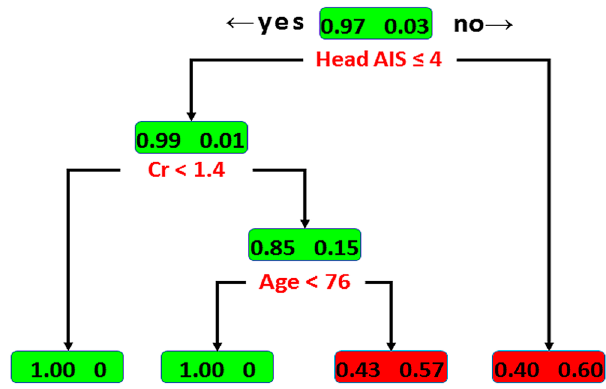
Figure 1. Illustration of the decision tree (DT) model for mortality of patients with isolated traumatic subarachnoid hemorrhage. The boxes denote the percentage of patients with discriminating variables from classification and regression tree (CART) analysis. Those who died and survived are indicated with the fractional number inside the right and left sides of the boxes, respectively.